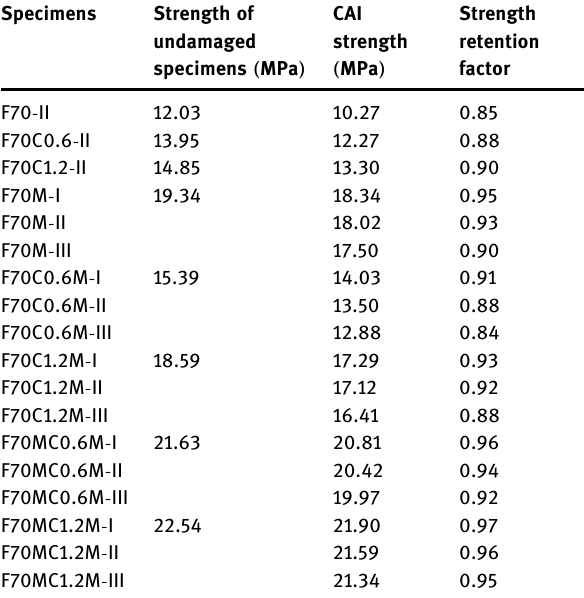
Table 3: Summary of edgewise compressive testing results